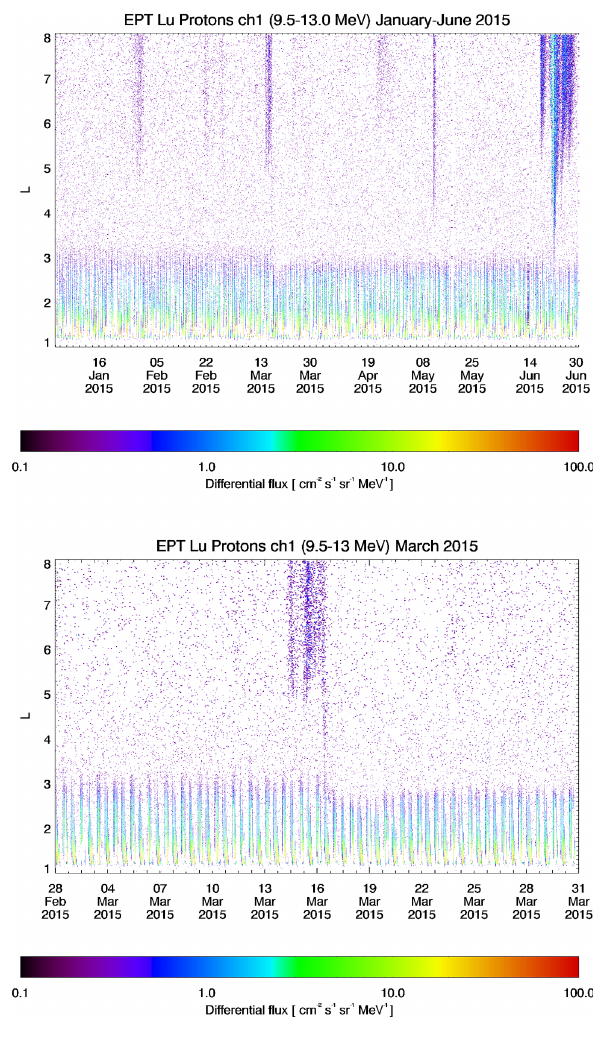
Figure 12. Proton fluxes observed by EPT/PROBA-V in Chan- nel 1 (9.5–13MeV) as a function of L between 1 January and 30 June 2015 (upper panel) and focused between 1 and 30 March 2015 (bottom panel) to emphasize that the March pro- ton injection starts on 15 March 2015 due to the arrival of solar energetic protons (SEP